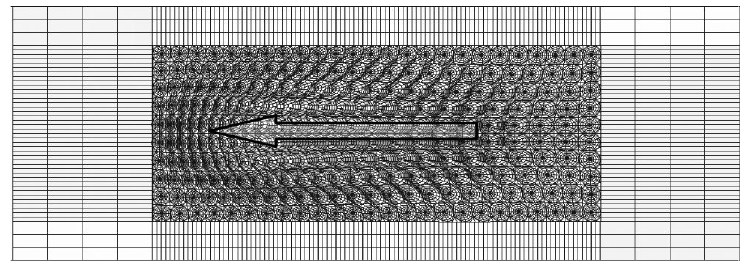
Fig. 41. EIDL 1st mode – 882 Hz – in plane uniform horizontal translation.